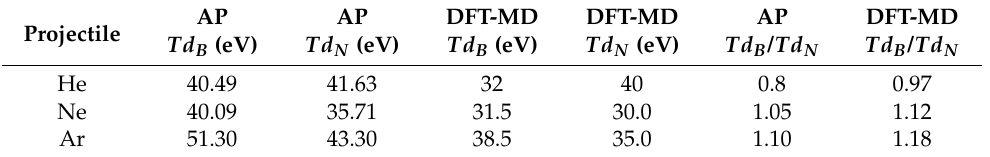
Table 1. Comparison of ion energies (displacement thresholds, T d ) required to displace boron/nitrogen atoms using the Born-Oppenheimer DFT MD (DFT-MD) and the employed analytical potential (AP).